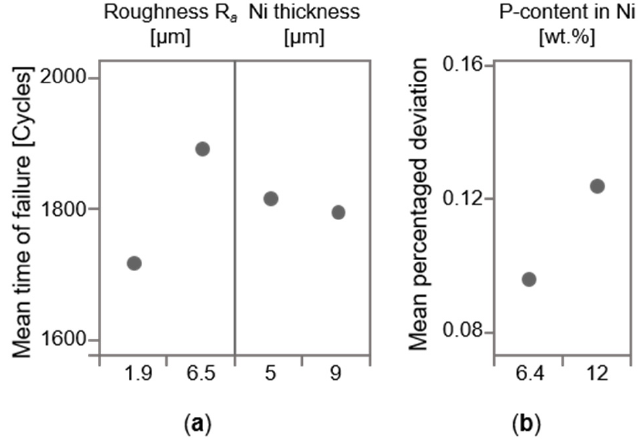
Figure 11. ( a ) Main and ( b ) minor influences extracted from thermal shock tests on samples prepared with the same laser and metallization parameters as for the flexural fatigue tests, but with the conductor track layout, which is displayed in Figure 4a.